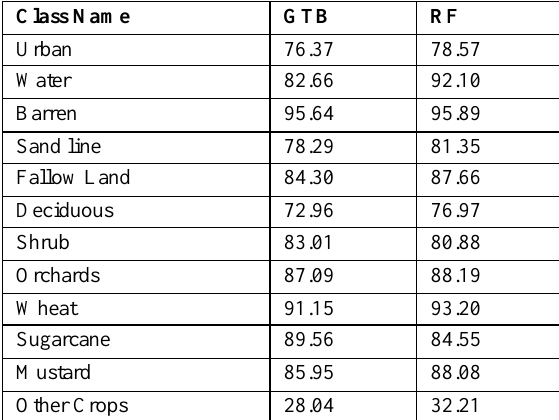
Table 5. F1 score of all classes by RF and GTB